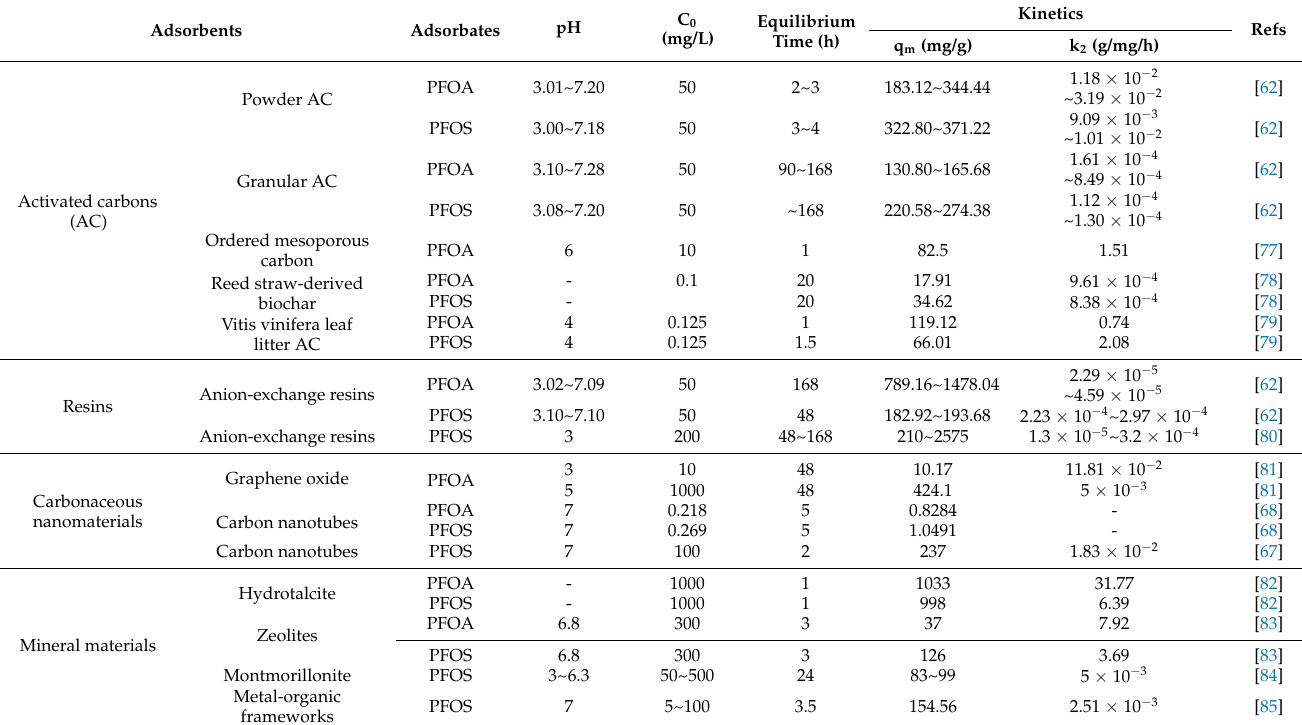
Table 3. Comparison of the adsorption performances of different adsorbents on